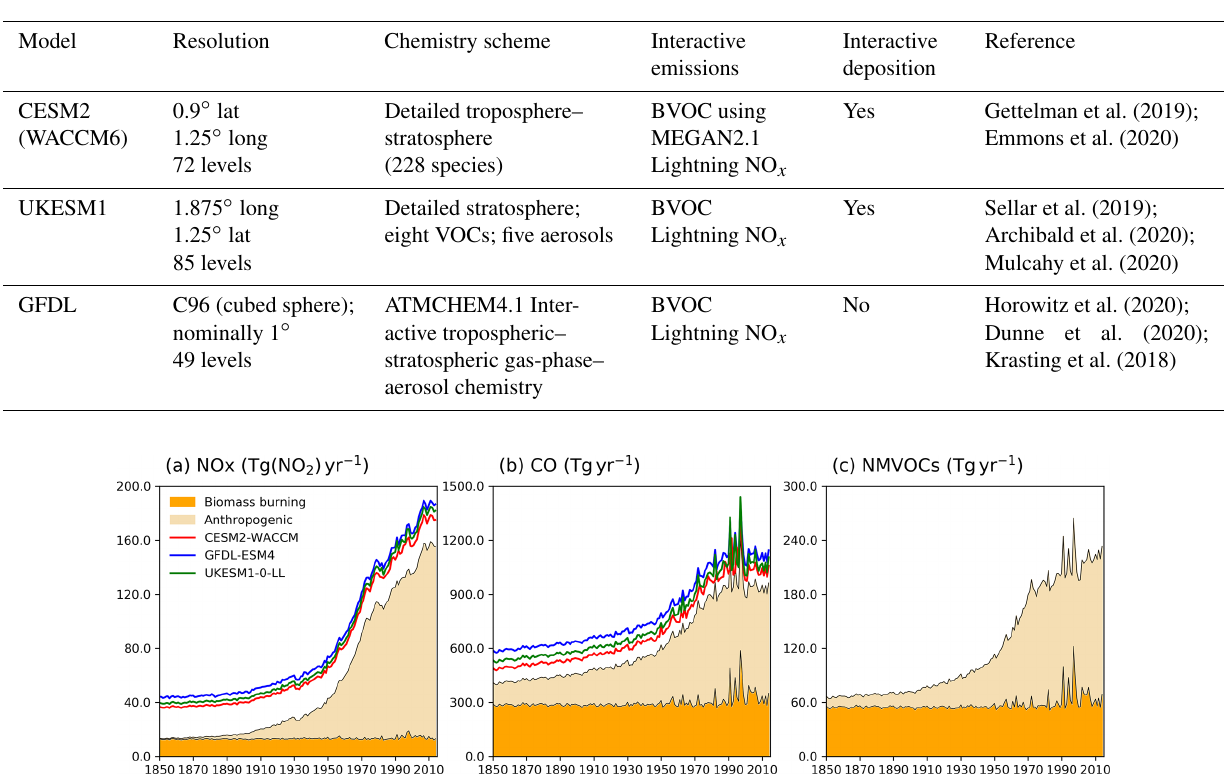
Table 1. Basic details of the AerChemMIP models analysed in this study. For more details, see the model references.